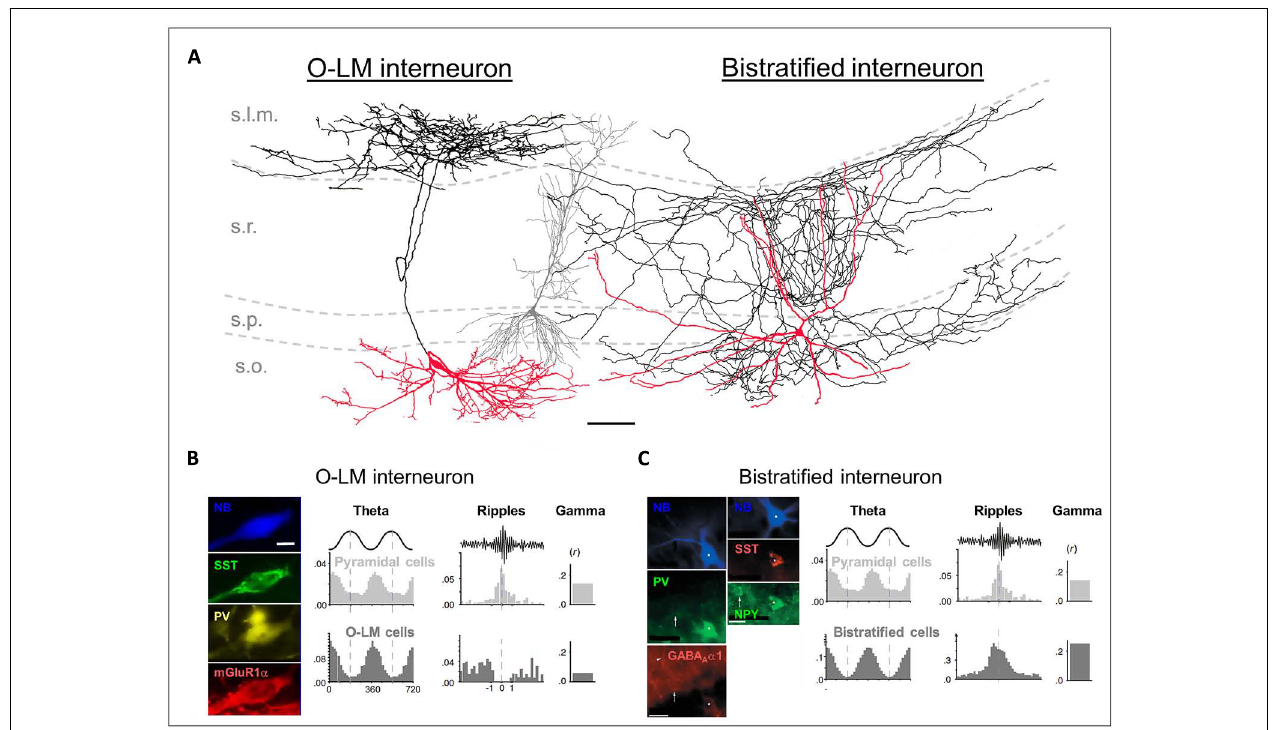
FIGURE 1 | (A) Reconstructions of an in vivo recorded neurobiotin-labeled (NB) O-LM interneuron (leftmost cell) and a bistratified interneuron (rightmost cell). Red: somata and dendrites; black: axons.The gray cell in the middle is a reconstructed pyramidal neuron for comparison. Scale bar: 100 μ m. (B) Left panels: the NB O-LM interneuron is immuno-positive for somatostatin (SST), parvalbumin (PV), and mGluR1 α . Right panels: in vivo firing probability histograms of pyramidal cells and of O-LM interneurons during theta and